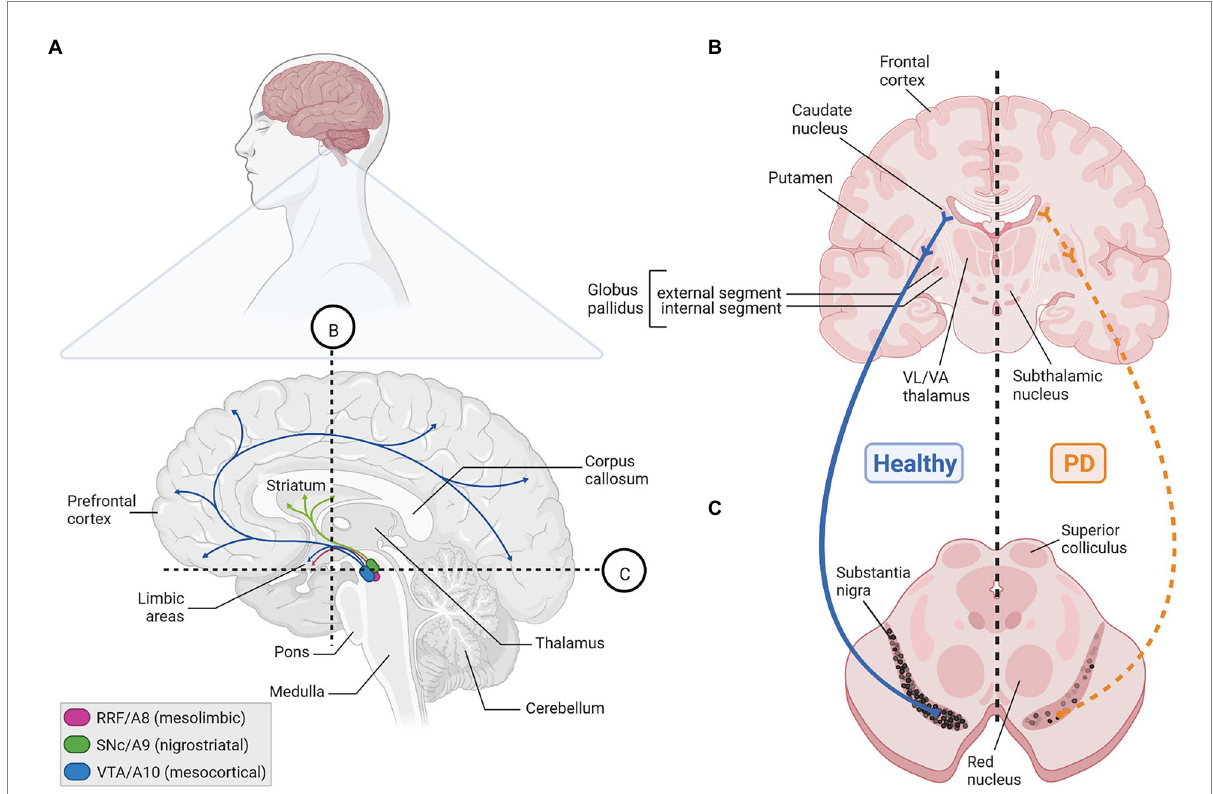
FIGURE 1 The human mDA system in the adult healthy and PD brain. (A) Sagittal view (upper) and enlarged parasagittal section (lower) of the adult human brain, showing the location of the cell bodies (ovals) from the A8 (RRF, pink), A9 (SNc, green), and A10 (VTA, blue) mDA clusters in the brainstem, and their projections (arrows) to the limbic areas (mesolimbic pathway), striatum (nigrostriatal pathway) and PFC (mesocortical pathway). Note that both the VTA and RRF DA neurons project to limbic areas in the mesolimbic pathway. Labeling of other structures (hypothalamus, etc.) and limbic regions, such as the NAc, olfactory tubercle, amygdala, septum, cingulate and perirhinal cortex, in this sagittal view have been omitted for clarity. (B,C) Cross-sections at the levels of the dotted lines in (A) through the human forebrain (B) and midbrain/brainstem (C) depicting the location of the projection areas and cell bodies, respectively, of the human SNc DA subset. In the healthy human brain (left side), dark pigmented (neuromelanin-containing) SNc DA neurons extend their axons into the caudate putamen, where they synapse onto their immediate target cells, the striatal GABAergic medium spiny neurons (MSN) and cholinergic and GABAergic fast spiking (FS) interneurons (INs). The MSN neurons project to the internal or external segment of the globus pallidus which, in turn, are connected with the ventrolateral (VL) and ventroanterior (VA) thalamus or subthalamic nucleus in what is known as the direct or indirect pathway, respectively, of the basal ganglia (not depicted here). Retrograde degeneration of the axons and subsequently of the pigmented cell bodies in the SNc (right side) is one key histopathological feature of the PD brain. Created with